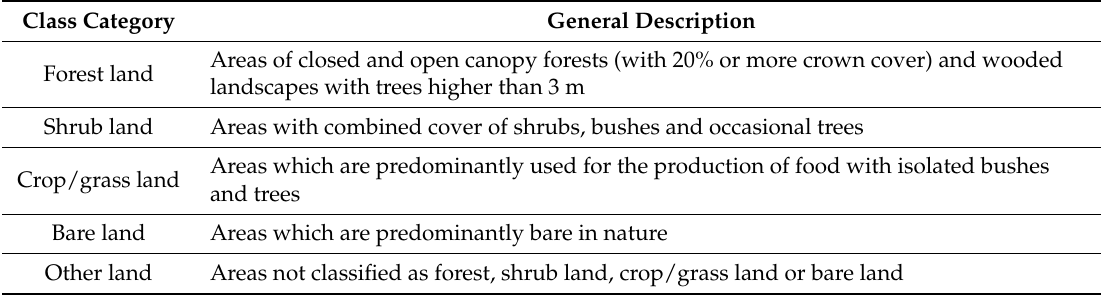
Table 1. Description of land use and land cover